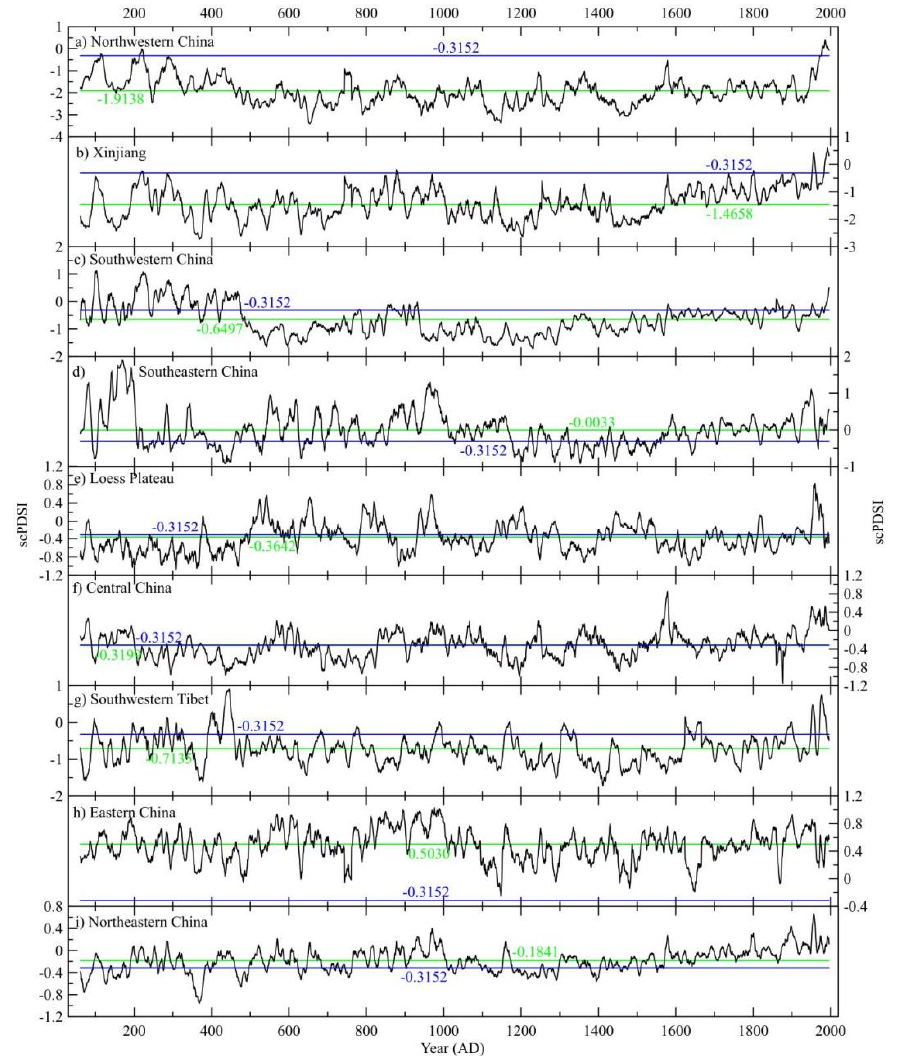
Figure 10. The dry-wet change of the reconstructed scPDSI of nine sub-regions. The green line represents the perennial average value of each sub-region, and the blue line represents the perennial average value of the whole of China.